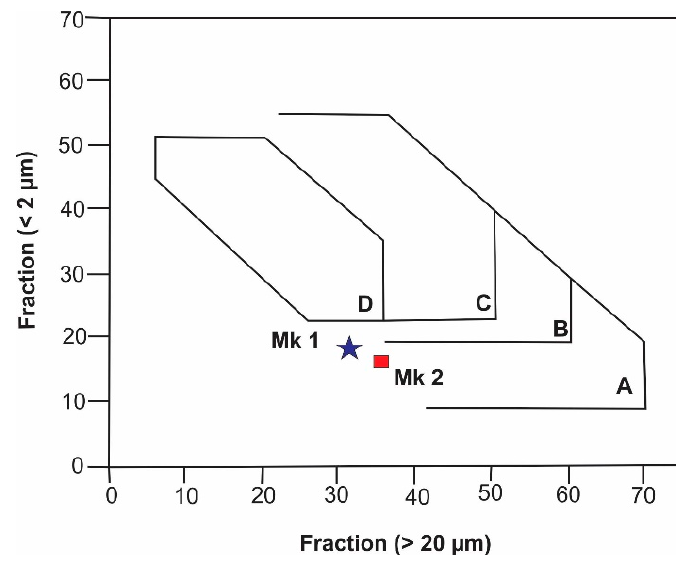
Figure 2. Grain size classification of raw clay materials according to Winkler’s diagram [32]. Fields indicate: (A) Common bricks, (B) vertically perforated bricks, (C) roofing tiles and masonry bricks, and (D) hollow products.